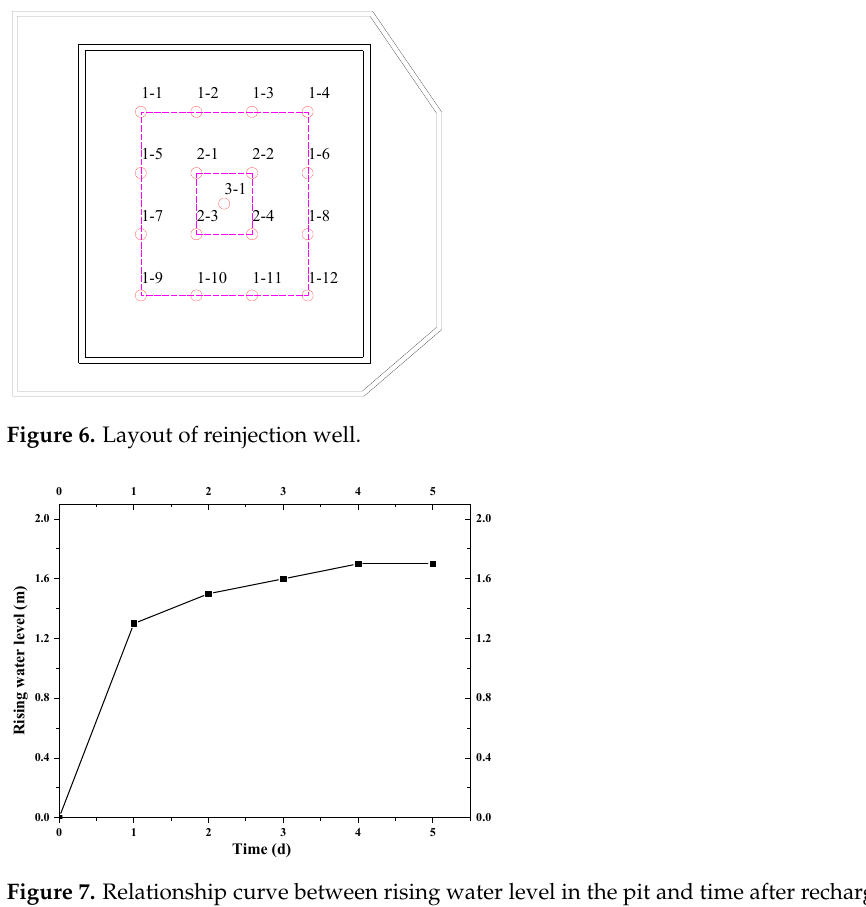
Figure 7. Relationship curve between rising water level in the pit and time after recharge. The outer circle recharge well was filled with 5000 mg/L (OD600 = 1.0) of S. pasteurii at a reinjection rate of 100 m 3 /d after the formation of stable seepage field. With the continuous injection of S. pasteurii solution, the bacteria were constantly migrating and expanding the coverage, as shown in Figures 8 and 9. The plane shape of the whole migration was roughly spindle because the seepage field formed by the reinjection of the inner circle reinjection well was flowing to the outside of the pit. In the vertical direction, the high concentration of S. pasteurii , which obviously affected MICP, was concentrated around the broken filter pipe of the reinjection well, and the concentration of the bacteria, which migrated deep down, was extremely low.